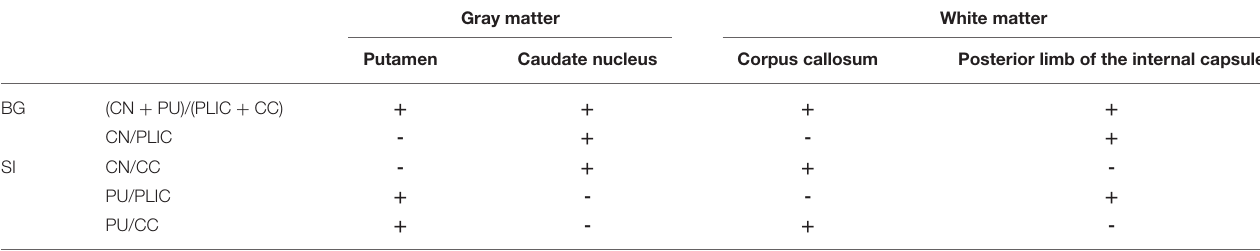
TABLE 1 | The Gray-white matter ratio at the basal ganglia (GWR-BG) in different locations. Gray matter White matter Putamen Caudate nucleus Corpus callosum Posterior limb of the internal capsule